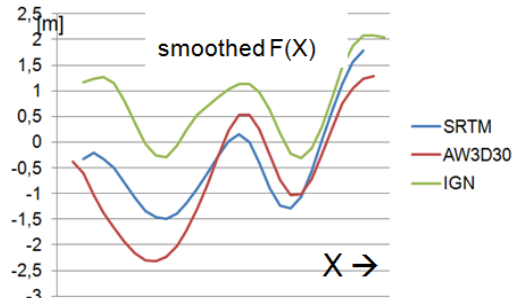
Figure 11. Smoothened systematic height differences of Ziyuan- 3 DSM against IGN reference, SRTM DSM and AW3D30 as function of X